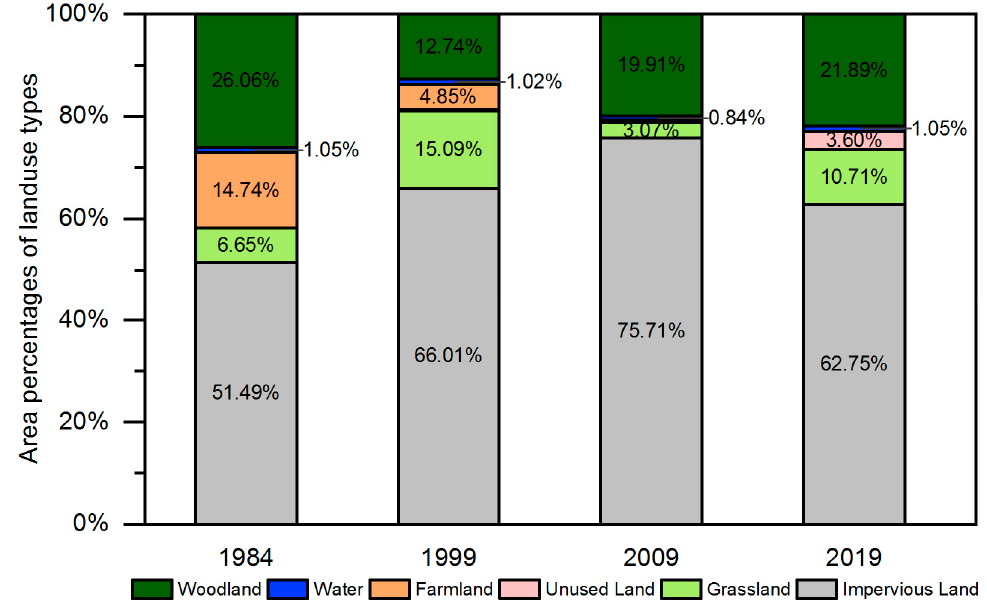
Figure 4. Percentage of land use types of the study area in 1984, 1999, 2009, and 2019.